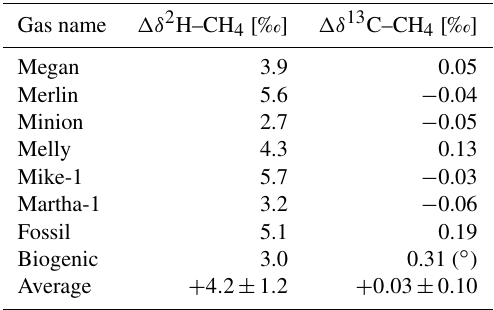
Table 6. Differences in δ 2 H–CH 4 and δ 13 C–CH 4 between pri- mary/secondary CH 4 gas calibrations and i SAAC measurements of the synthetic CH 4 -in-air standards using the scale anchor based on Carina-1. Differences are calculated as δ i SAAC – δ pure . The bottom line shows the average and the standard deviation (1 σ) of consid- ered differences, excluding the value of Biogenic ( ◦ ) as described in main